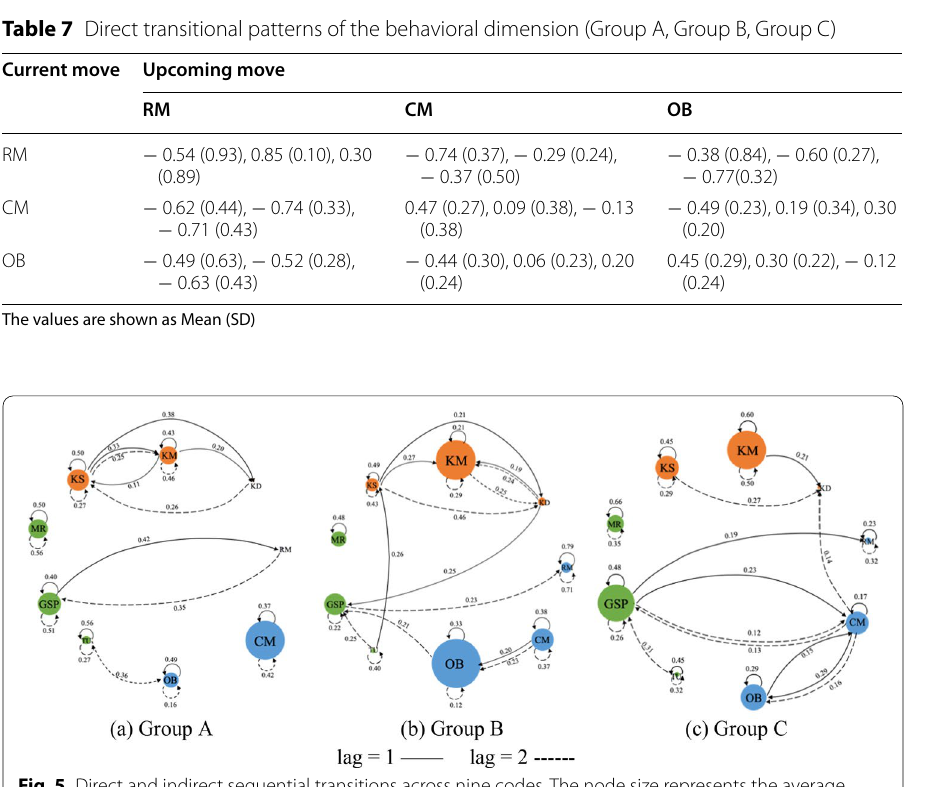
Fig. 5 Direct and indirect sequential transitions across nine codes. The node size represents the average code frequency of the groups throughout four CPS activities. The values on the solid and dashed lines represent Yule’s Q values when lag is set to 1 and